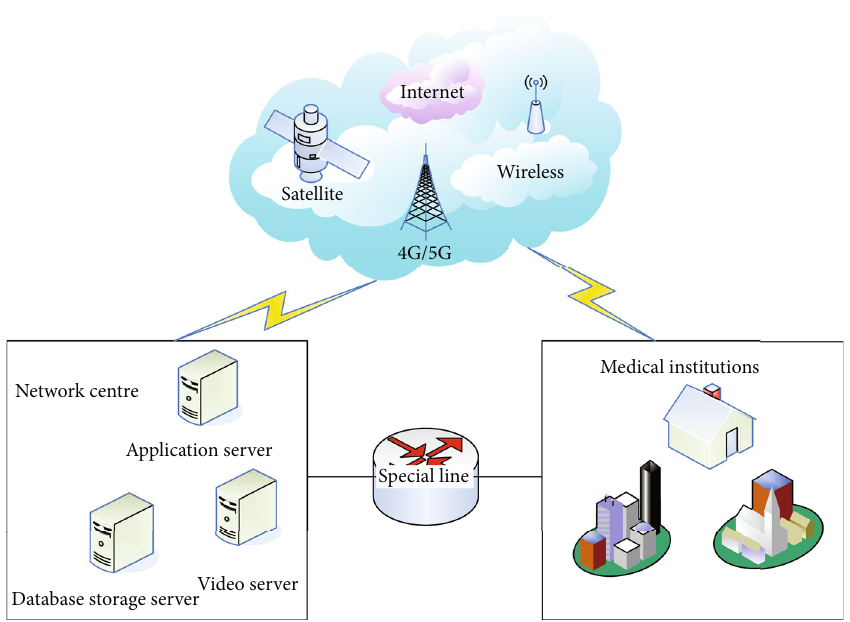
Figure 2: Mobile